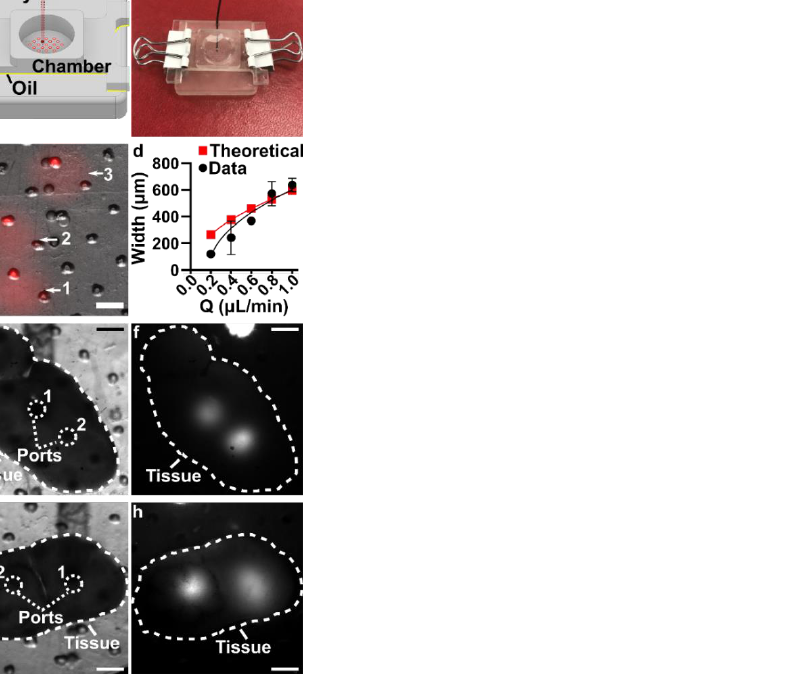
Figure 5. Demonstration of local delivery to slices of hydrogel and live tissue. ( a ) A schematic and ( b ) an image of the assembled two-component device, with red solution filled into the delivery channel for visualization. ( c ) Image after three deliveries of fluorescent dextran (red) to a slab of transparent agarose. Scale bar 500 µm. Numbers indicate the order of the sequential deliveries. Overlaid fluorescent and brightfield data. ( d ) Plot of delivery width as a function of flow rate (mean ± Std Dev, n = 3). Experimental data (black circles) were fit with a square root function, √ y = 663 x − 0.178, R 2 = 0.85. Red squares indicate theoretical prediction (Equation (2)). ( e – h ) Images showing multiple deliveries to replicate tissue slices. ( e , g ) Brightfield image of the slice of lymph node tissue (outlined in dashed while line) in the assembled device prior to delivery. The ports used for sequential deliveries (white dotted lines) are indicated, with the order of delivery numbered. Scale bar 500 µ m. ( f , h ) Fluorescent image after two deliveries of FITC-labeled dextran (white signal) to the live tissue